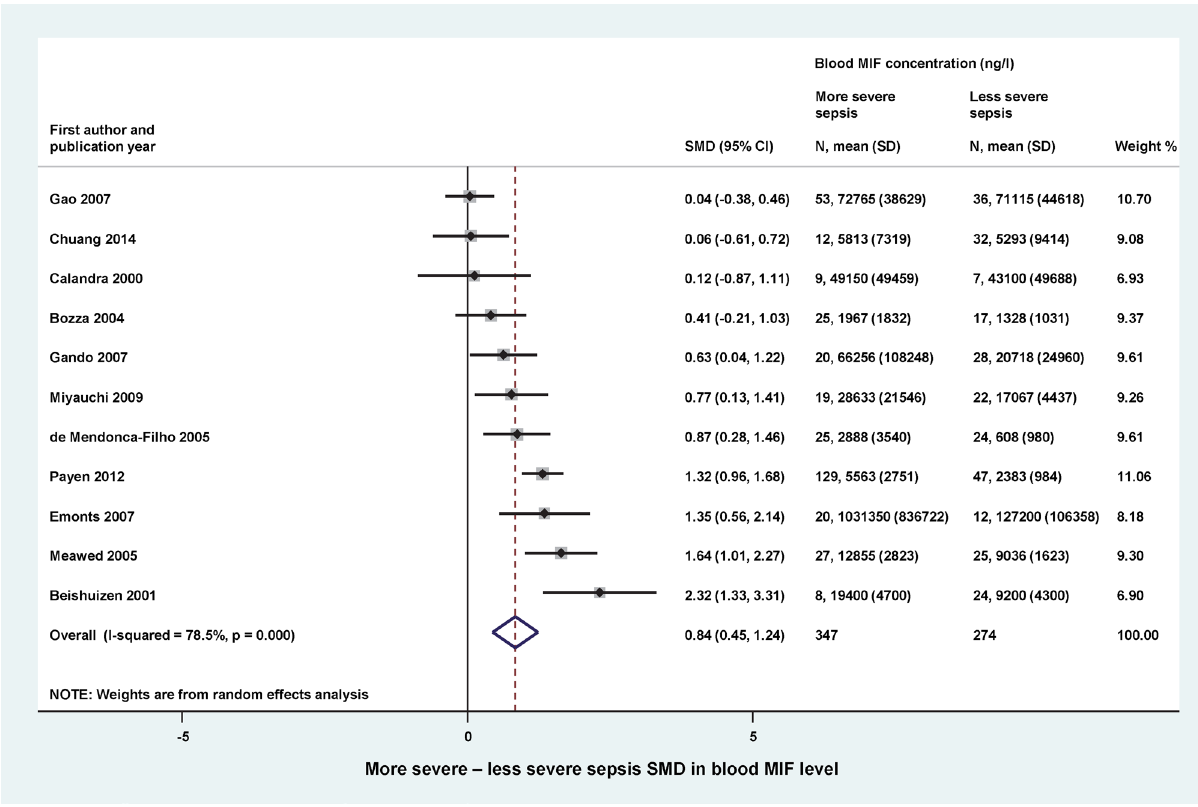
Figure 5. Forest plot of standardized mean differences (SMDs) in blood levels of macrophage migration inhibitory factor (MIF) between patients with more severe and less severe forms of sepsis. CI confidence interval, SD standard